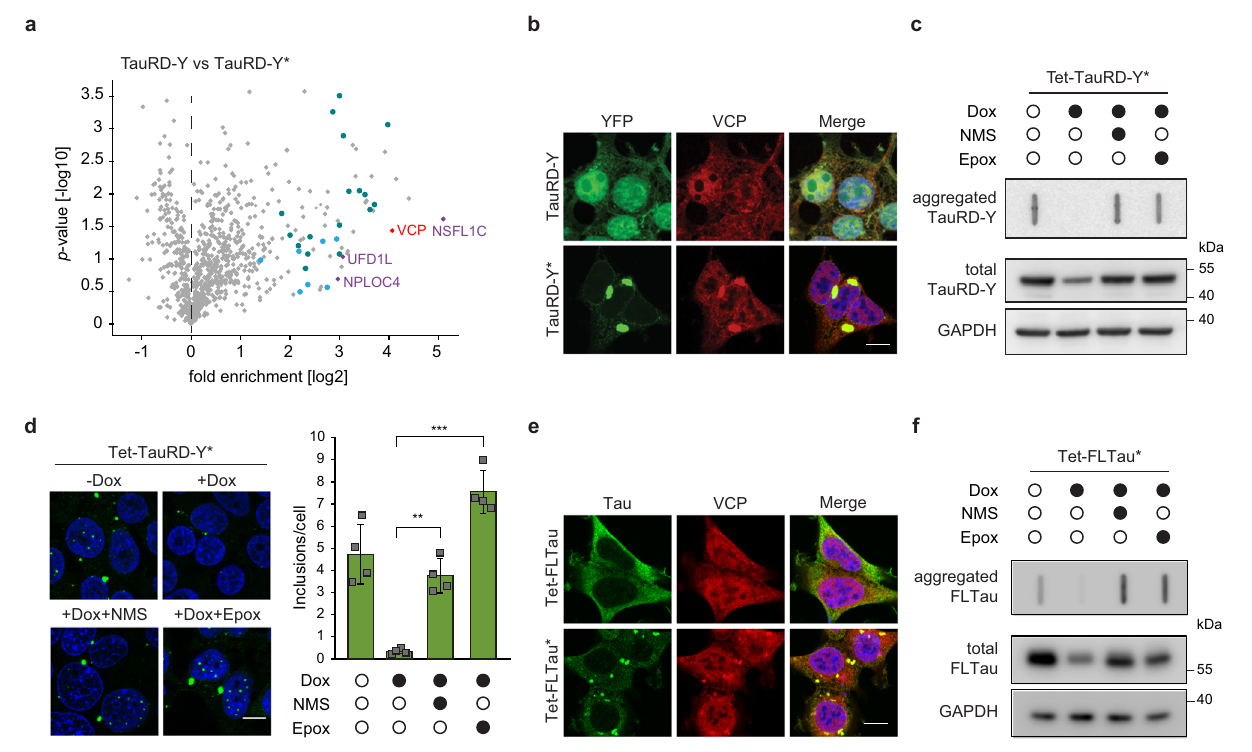
Fig. 2 | Disaggregation of Tau aggregates is dependent on VCP activity. a Volcano plot of TauRD-Y interactome from TauRD-Y and TauRD-Y* cells. Unla- beled green and blue symbols represent proteasome subunits of 19S and 20S, respectively. VCP and its cofactors are highlighted. P-values from one-sample test. b Association of VCP with TauRD-Y inclusions. Immuno fl uorescence staining of VCP(red)andYFP fl uorescenceofTauRD-Y(green)inTauRD-YandTauRD-Y*cells. Representative images from at least three independent experiments are shown. Scalebar,10 µ m. c FiltertrapanalysisoflysatesfromTet-TauRD-Y*cellstreatedfor 24h with doxycycline (Dox; 50ng/mL) alone or in combination with NMS-873 (NMS; 2.5 µ M) or Epoxomicin (Epox; 50nM). Aggregated and total TauRD-Y levels were determined by immunoblotting against GFP. GAPDH served as loading con- trol. Representative blots from at least three independent experiments are shown. d Left, representative images of Tet-TauRD-Y* cells treated as in ( c ). Scale bar,